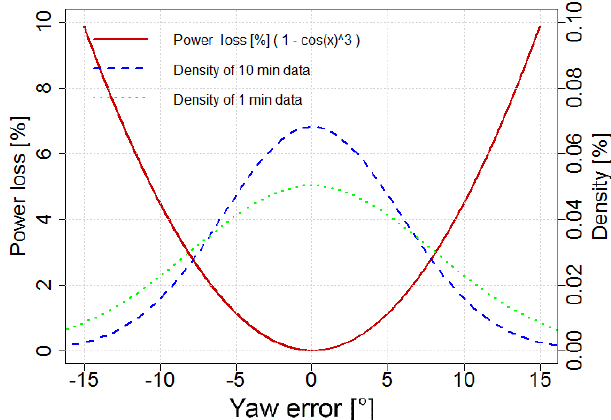
Figure 5. The red solid line indicates the power loss as a function of the yaw error, assuming the cubic-cosine relationship. The dot- ted and dashed lines represent data densities, fitted with Gaussian distributions. Both lines are based on the same raw data with 1Hz resolution, but the green dotted distribution shows the data with an averaging period of 1min and the blue dashed line is the data with 10min averaging. Higher data resolution (e.g., 1min data instead of 10min data) has a larger standard deviation and therefore provides more data points at extreme conditions where the effects of power losses are more pronounced. This enables better evaluation of the best point of